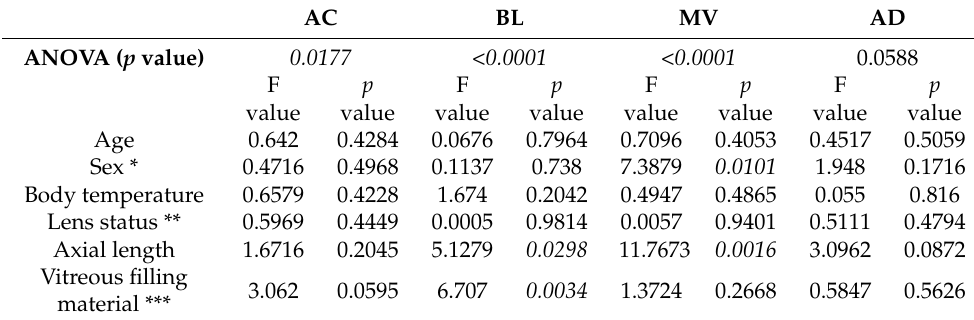
Table 4. Clinical factors that influence on the intravitreal temperature at each